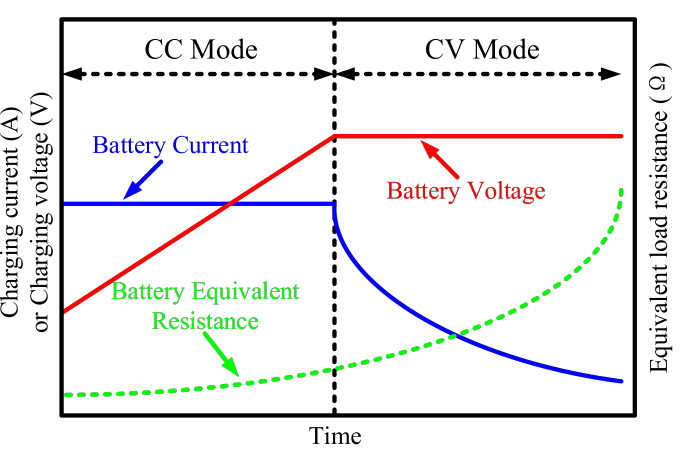
Figure 7. Illustration of constant current and constant voltage charging or discharging mode of batteries [34].